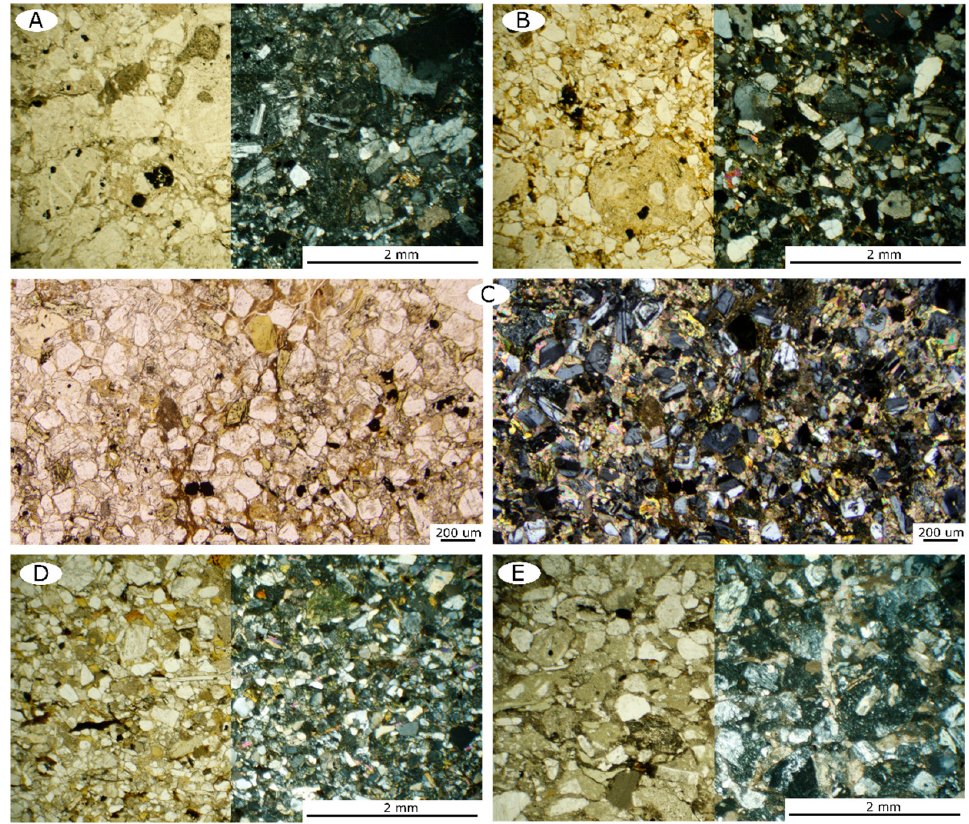
Figure 4. Thin section photographs of the reviewed Formations. ( A ): volcaniclastic layer within the Taveyanne Sandstones. ( B ): Polylithological layers from the Taveyanne Sandstones. ( C ): plagioclase-arenite layer from the Cibrone Formation. ( D ): polylithological layer from the Val d’Aveto Formation with volcanic rock fragments. ( E ): volcaniclastic layers from the Val d’Aveto Formation. Parallel nichols on the left side and crossed nichols on the right side of ( A – E ).